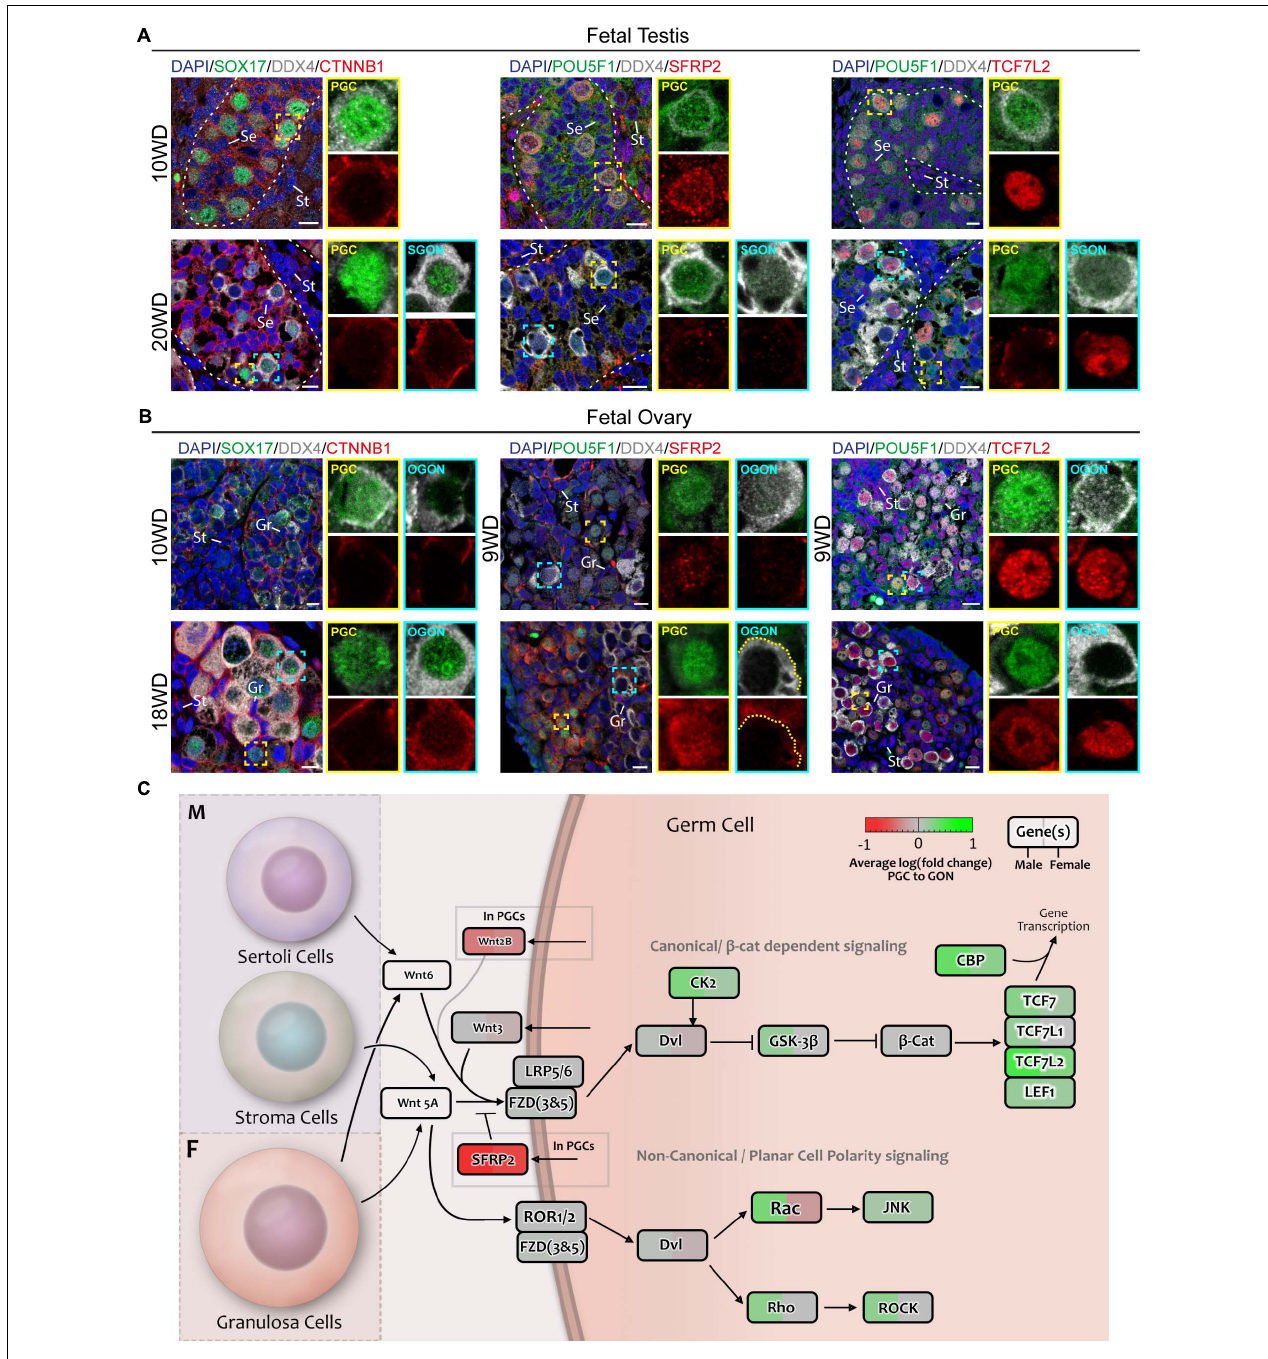
FIGURE 6 | Analysis of WNT signaling effectors and downstream targets in fetal gonads by immunostaining. (A) Immunofluorescence of CTNNB1, SFRP2, or TCF7L2, with DDX4 and POU5F1 or SOX17 in the first trimester (10 WD, top) or second trimester (20 WD bottom) fetal testis. No nuclear CTNNB1 is observed in germ cells, suggesting that canonical WNT signaling is not active. SFRP2 expression is age dependent, being expressed in 10-WD PGCs, but not 20-WD PGCs. In 20 WD germ cells, TCF7L2 is upregulated in GONs (POU5F1 − ). Yellow boxes indicate zoom-in of a PGC (POU5F1 + ), and cyan boxes indicate zoom-in of a GON (POU5F1 − ). Se, St, and Gr annotate Sertoli, stromal, and granulosa cells, respectively. Scale bar indicates 10 µ m. (B) Immunofluorescence of CTNNB1, SFRP2, or TCF7L2, with DDX4 and POU5F1 or SOX17 in the first trimester (9 or 10 WD, top) or second trimester (18 WD, bottom) fetal ovary. Faint staining of CTNNB1 is observed in some 18-WD GONs, suggesting (modest) activation of canonical WNT signaling. SFRP2 expression is highly upregulated in PGCs compared to GONs, especially in 18-WD ovary. TCF7L2 is expressed in both PGC and OGONs. (C) A schematic model of active signaling WNT axes in germ cells representing a combination of results from CellphoneDB analysis and differentially expressed gene analysis. Genes upregulated in GONs are depicted in green, while those upregulated in PGCs are depicted in red.